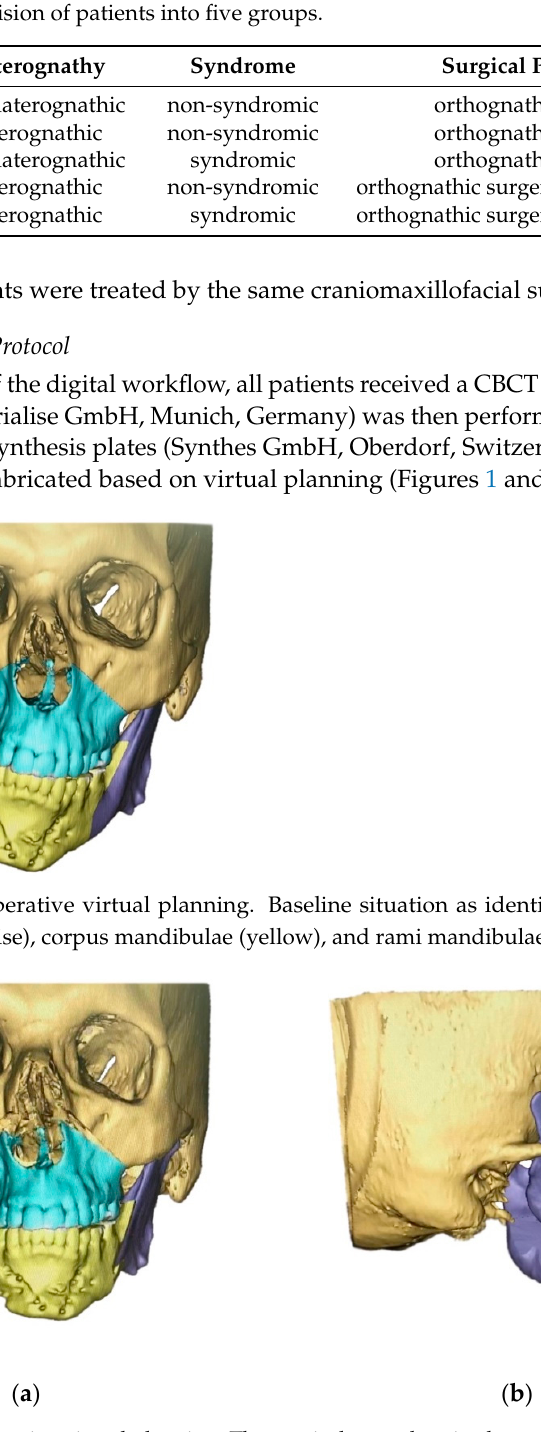
Figure 2. Preoperative virtual planning. The surgical procedure is planned virtually in advance and the three jaw components (maxilla (turquoise), corpus mandibulae (yellow) and rami mandibulae (purple)) are aligned three-dimensionally in position, tilt, and rotation. ( a ) Frontal view, ( b ) lateral